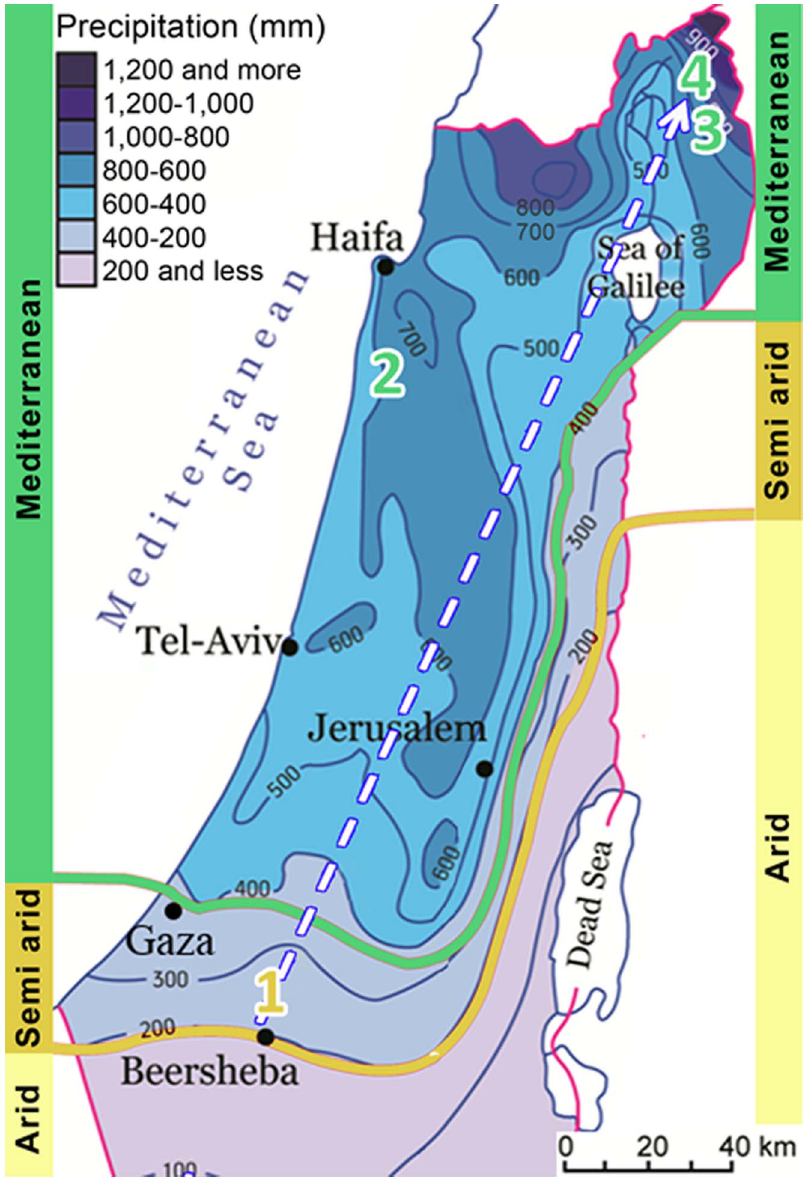
Figure 2. Study sites along the climatic gradient (white arrow). 1, Goral; 2, Nadiv; 3, Bashan; and 4, Golan. For more details see Table 1. The map was modified from: Israel: People and place (2007), with permission from Fein et al. (Fein Z, Segev M, Lavi R 2007, Israel: People and place. Cartography, Soffer R, Center for Educational Technology, Israel).